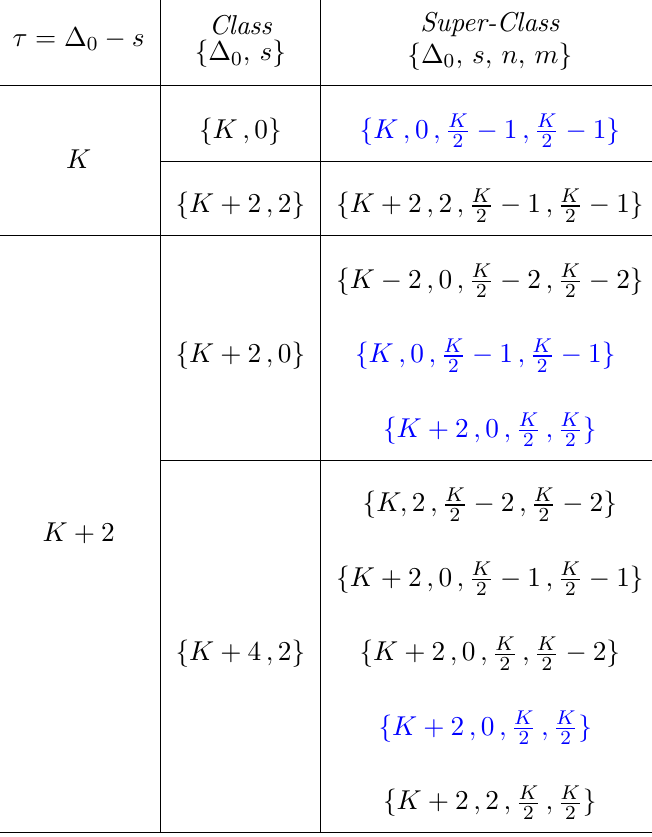
Table 4 . Twist, primaries and super-primaries. The super-multiplets mixed in the ordinary con- formal expansion of the asymptotic four-point function for leading and sub-leading twists. We highlight in blue the super-primary classes which contribute to more than one primary